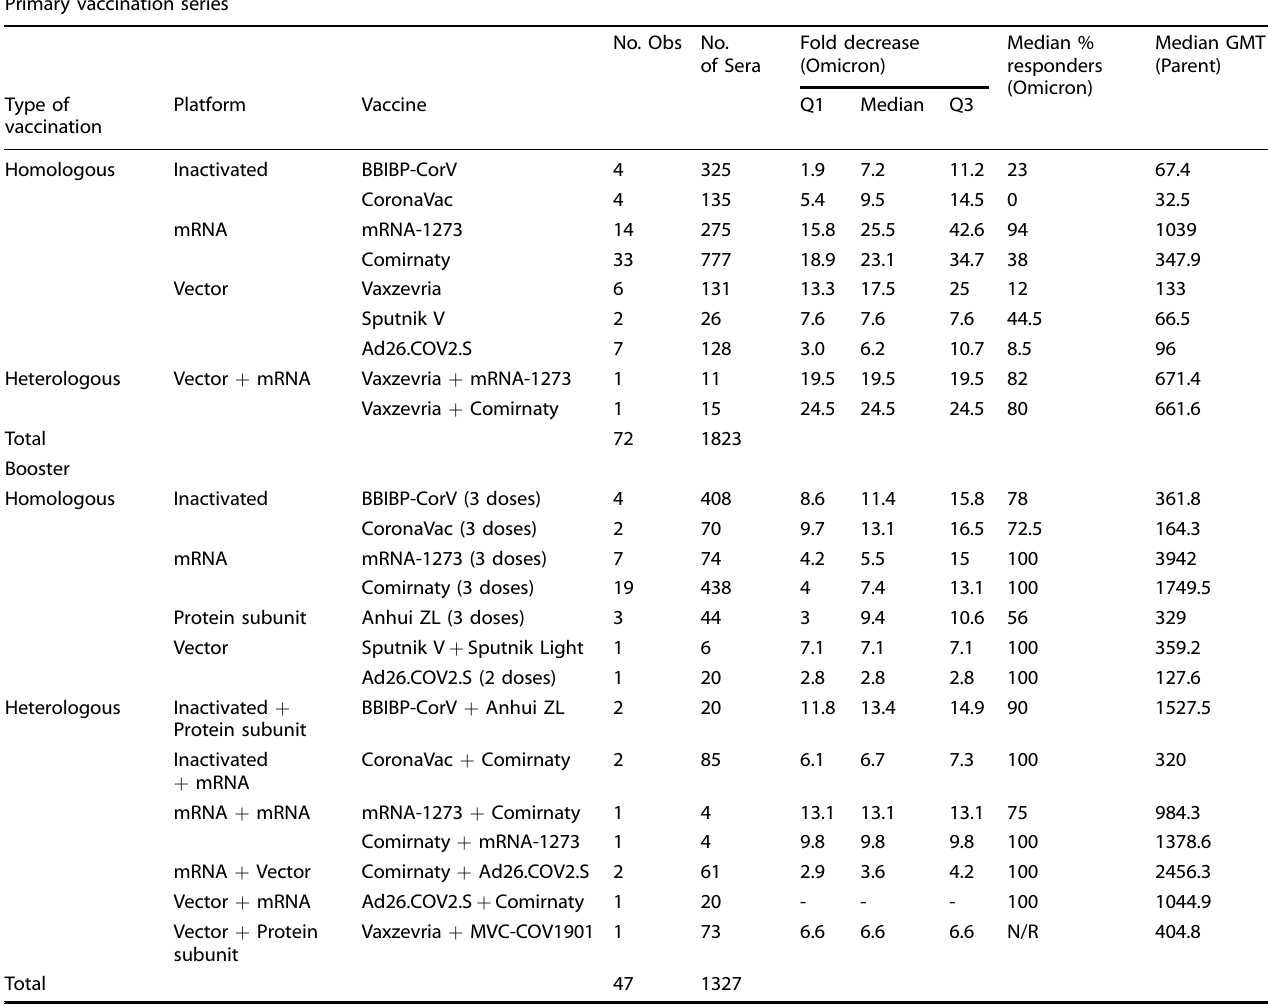
Table 1. Overview of studies and results. Primary vaccination